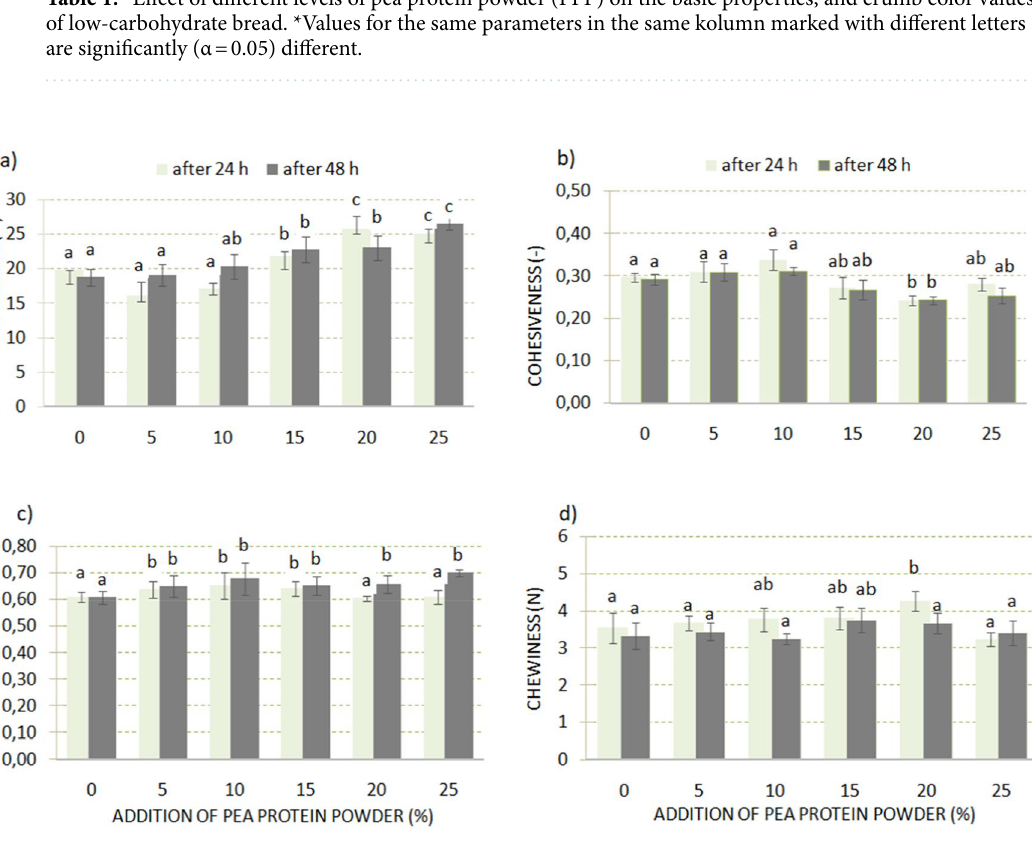
Figure 2. Changes of textural crumb properties of low-carbohydrate bread as a result of PPP addition: ( a ) hardness, ( b ) cohesiveness, ( c ) springiness, ( d )chewiness; mean values in the same figure marked with different letters are significantly (α = 0.05)